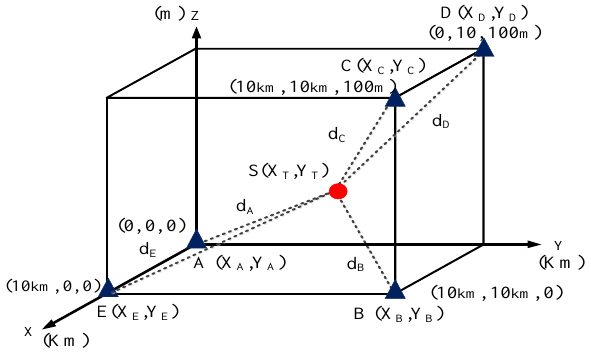
Figure 11. The 3D locating error analysis of monitoring/locating station (sensor